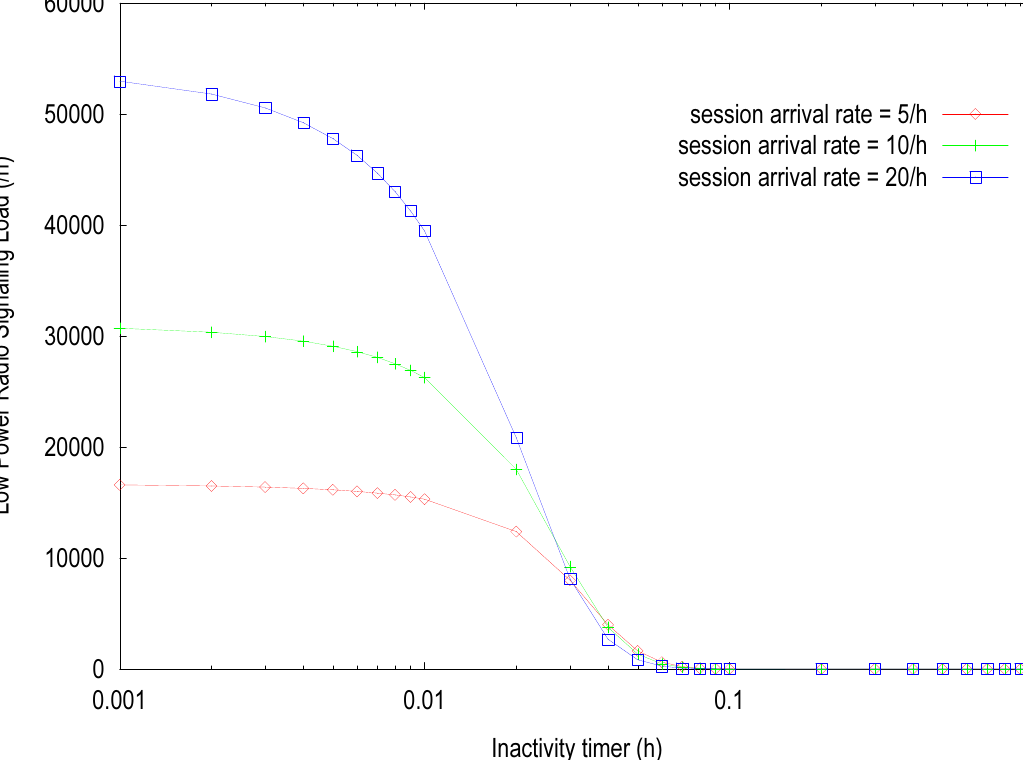
Figure 10. Low-power radio signaling load by varying the session arrival rate (small values of T and T E W